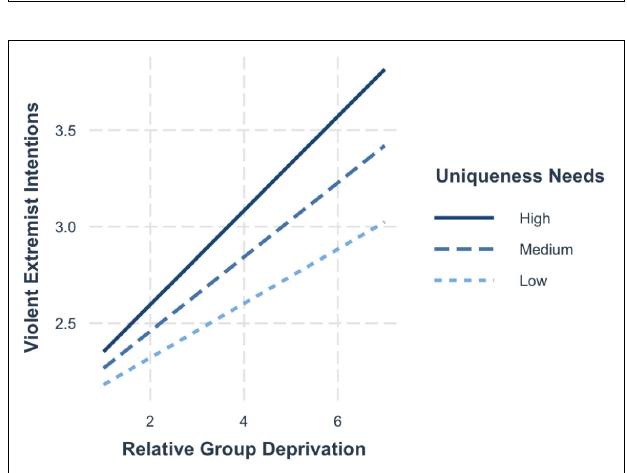
FIGURE 2 | Simple slopes for group deprivation and need for uniqueness on violent extremist